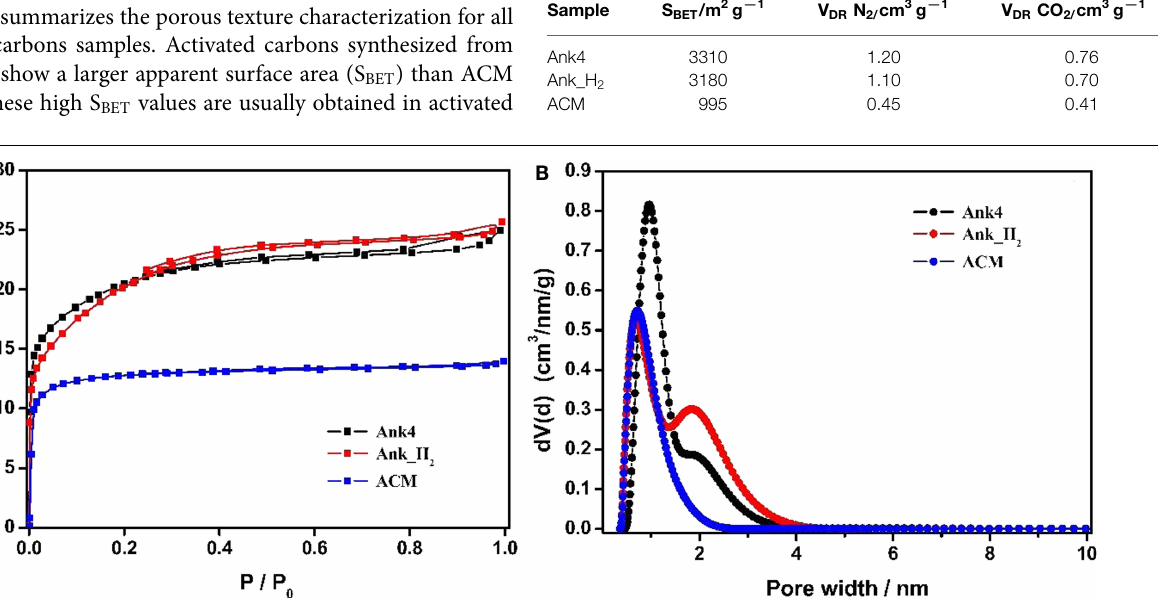
TABLE 1 | Porous texture values of all activated carbon samples .